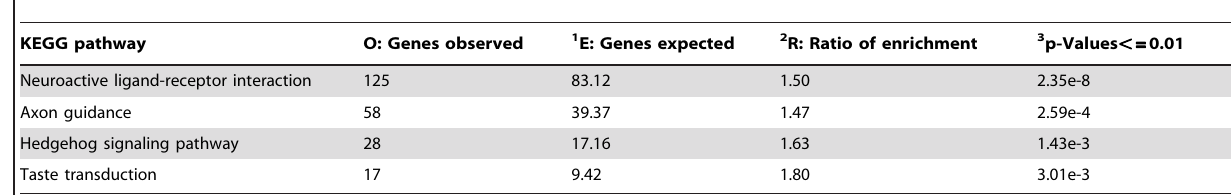
Table 3. The only four significantly enriched KEGG pathways for graded genes ( p , =0.01).